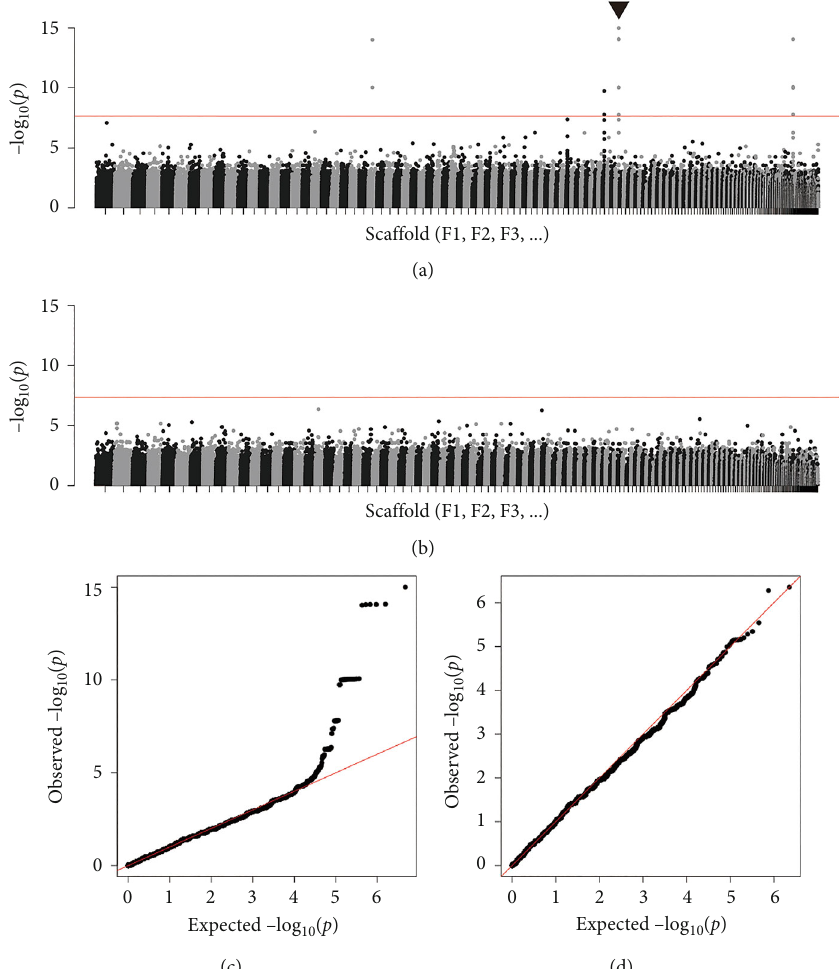
Figure 5: Genome-wide association with the sex of PBT using the female reference sequences. For the unmasked (a and c) and masked (b and d) references, Manhattan plot and Q-Q plot are shown, respectively. In Manhattan plots, genome-wide signi fi cance cuto ff s based on Bonferroni ’ s correction are indicate by a red line, and the signi fi cant peak in sca ff old F64 is indicated by a triangle. P values lower than 10 -15 are treated as 10 -15 for